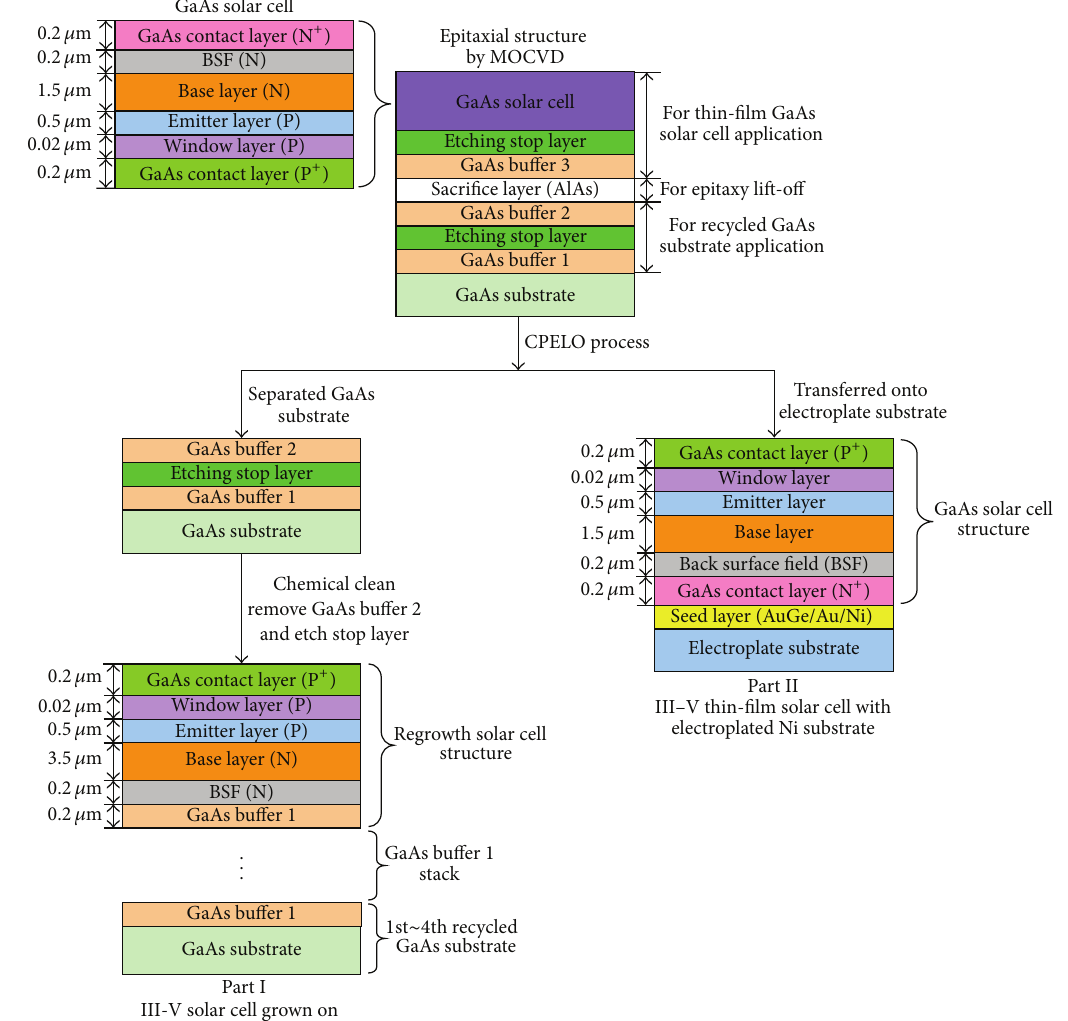
Figure 1: Device fabrication flowchart of experiment